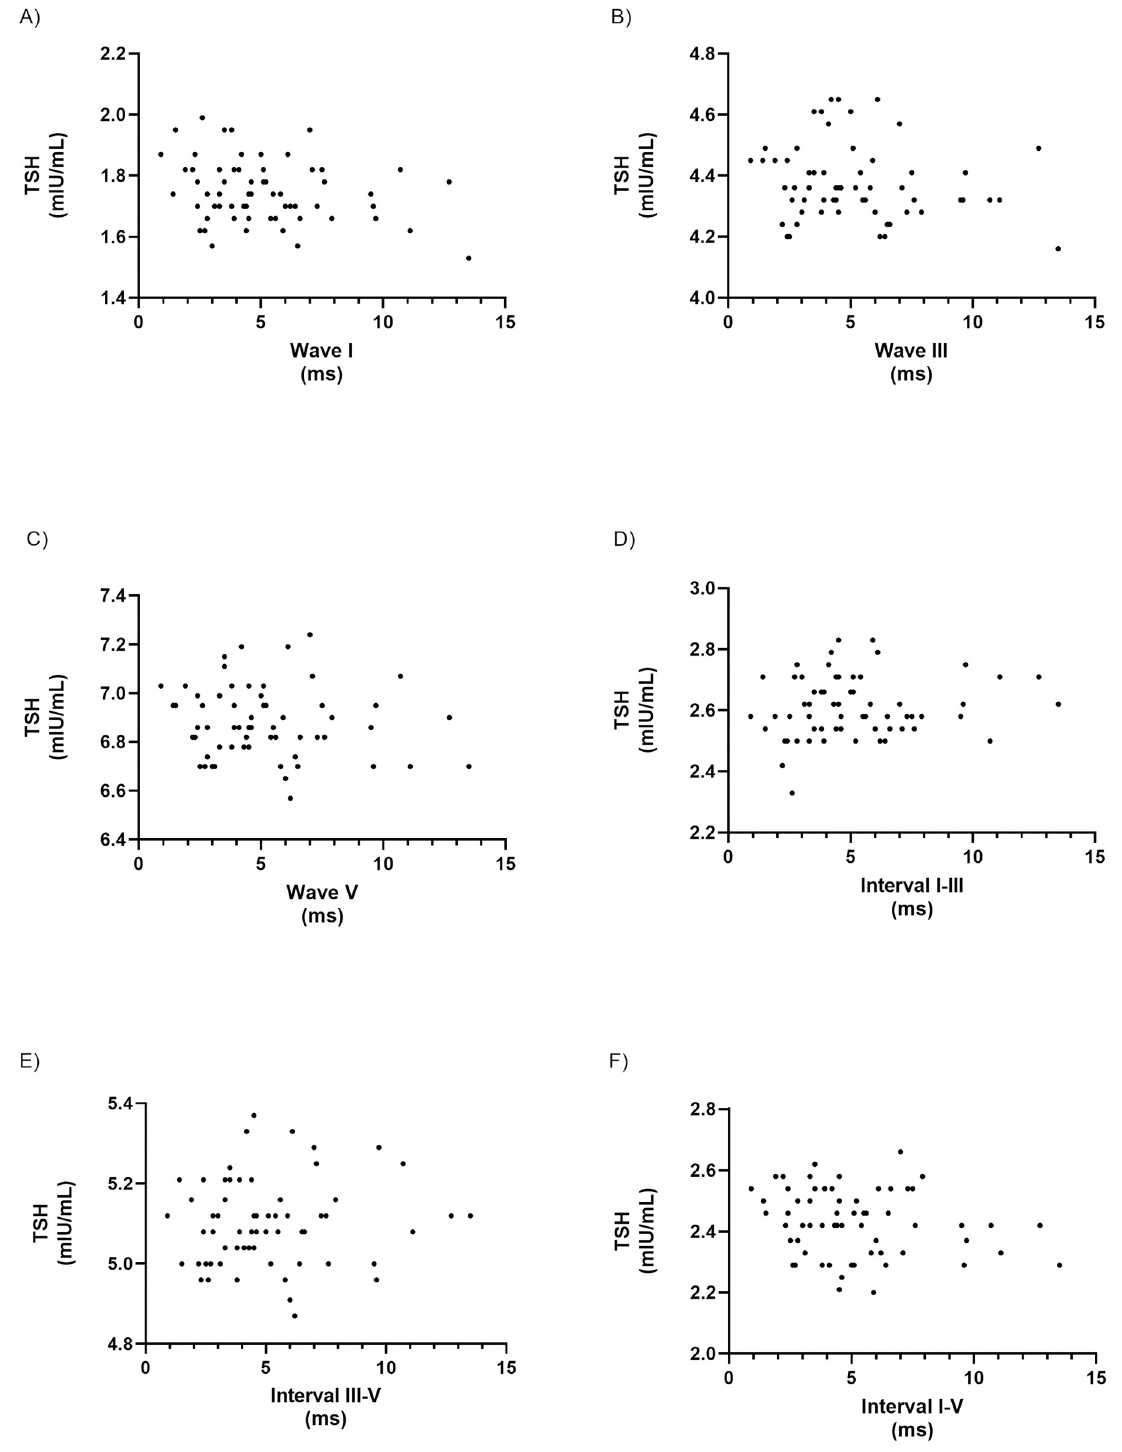
Fig 1. Scatter plot graphs. TSH levels ( μ UI/mL) vs wave I (A), wave III (B), wave V (C), and intervals I–III (D), III–V (E), I–V (F) latencies in milliseconds (ms).